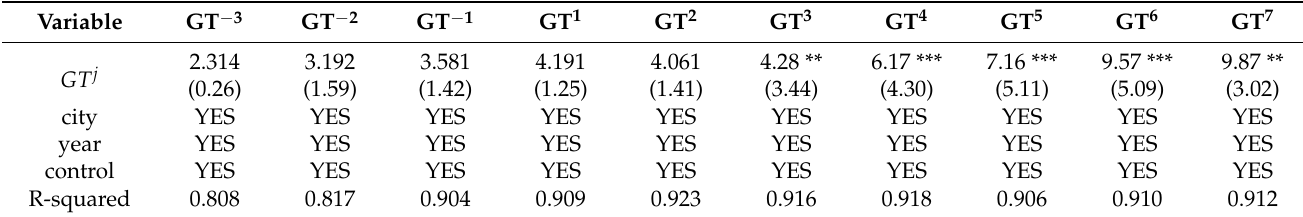
Table 7. Time effect analysis of GZR urban innovation dividend (talent level).